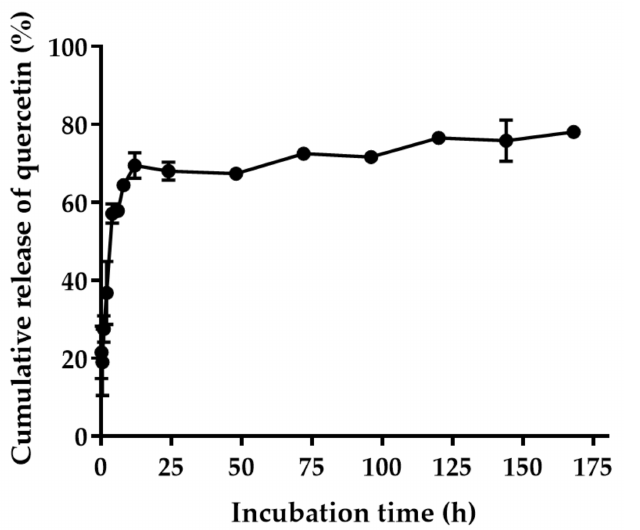
Figure 5. The cumulative release of quercetin from the quercetin-loaded PLGA NPs in phosphate buffer saline, pH 7.4, at 37 ◦ C.